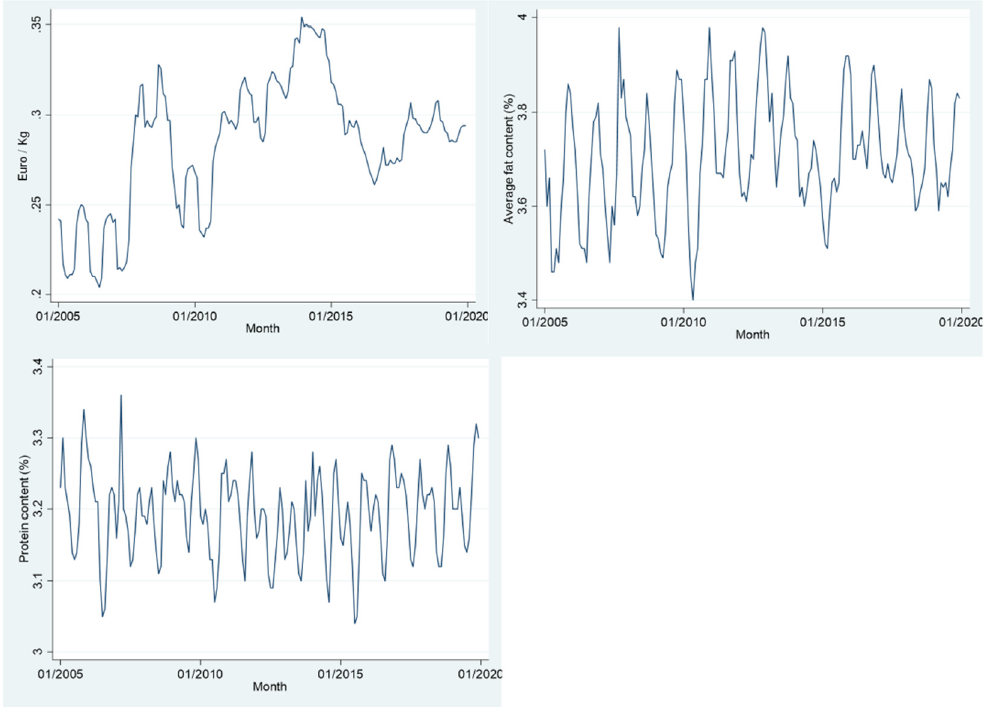
Figure 3: Average monthly prices and characteristics ( 2005 – 2019 ) in the Azores for milk purchased from individual producers ( producers have a refrigeration tank on the farm; transport is arranged by the factory )